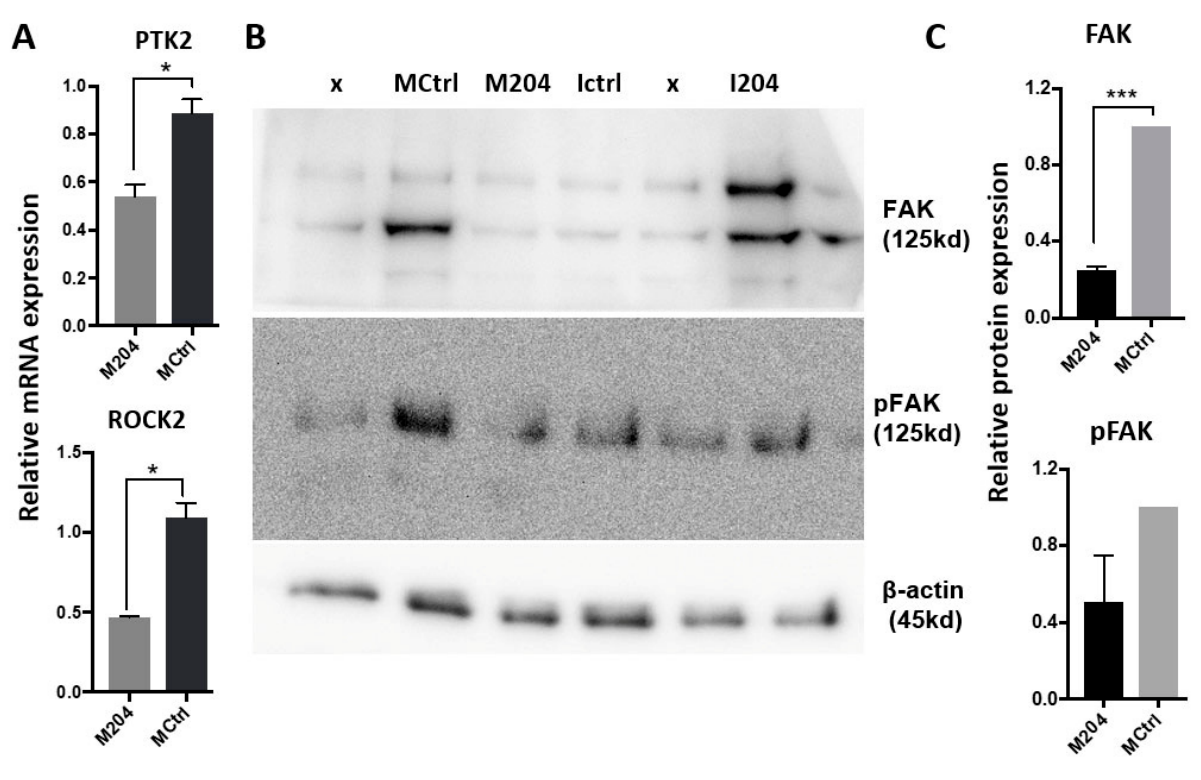
Figure 7. Changes in ( A ) mRNA and ( B ) protein expression following miR-204 modulation in CAFs. Western blot image ( B ) and the semi-quantification of protein blots using ImageJ ( C ) (* p < 0.05, *** p < 0.0005).